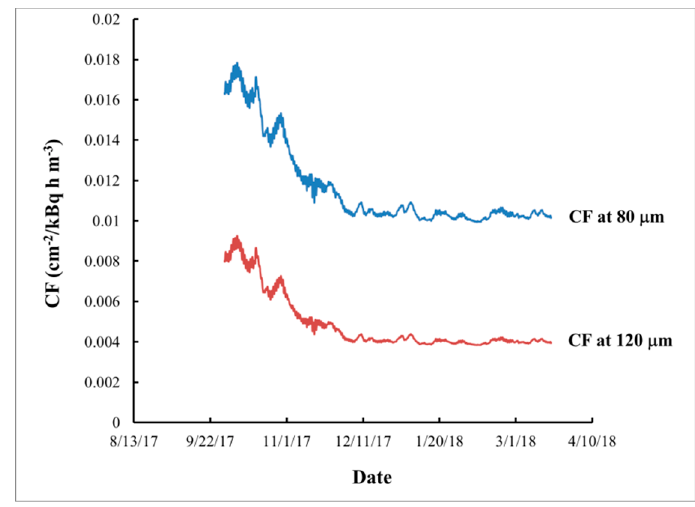
Figure 8. Dependence of the modeled calibration factor [11] on time at depths of 80 µ m and 120 µ m.